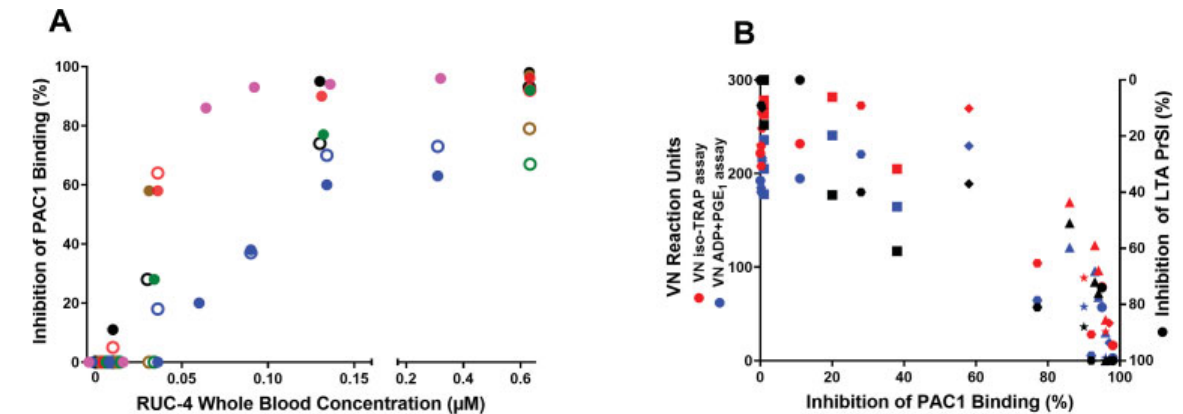
Fig. 2 Correlation of PAC1 binding, re fl ecting the α IIb β 3 receptors not occupied by RUC-4, with RUC-4 whole blood concentration and inhibition of the VN and LTA assays in blood anticoagulated with PPACK and treated with aspirin. ( A ) Percentage inhibition of fl uorescently-labeled PAC1 binding to ADP-activated platelets as a function of RUC-4 whole blood concentration. RUC-4 was added to whole blood and then both whole blood (open circles; n ¼ 5; 24 measurements) and PRP prepared from that blood ( fi lled circles; n ¼ 6; 30 measurement) were activated with ADP (20 µM) and analyzed by fl ow cytometry. Each color signi fi es a different volunteer. ( B ) Percentage inhibition of PAC1 binding to ADP-activated platelets in PRP versus the 2 different VN assays (left axis) and inhibition of ADP (20 µM)-induced LTA PrSl (right axis). Each shape signi fi es a different volunteer, each color signi fi es a different assay. VN ¼ VerifyNow; LTA ¼ Light transmission aggregometry; PRP ¼ Platelet-rich plasma; PrSl ¼ Primary